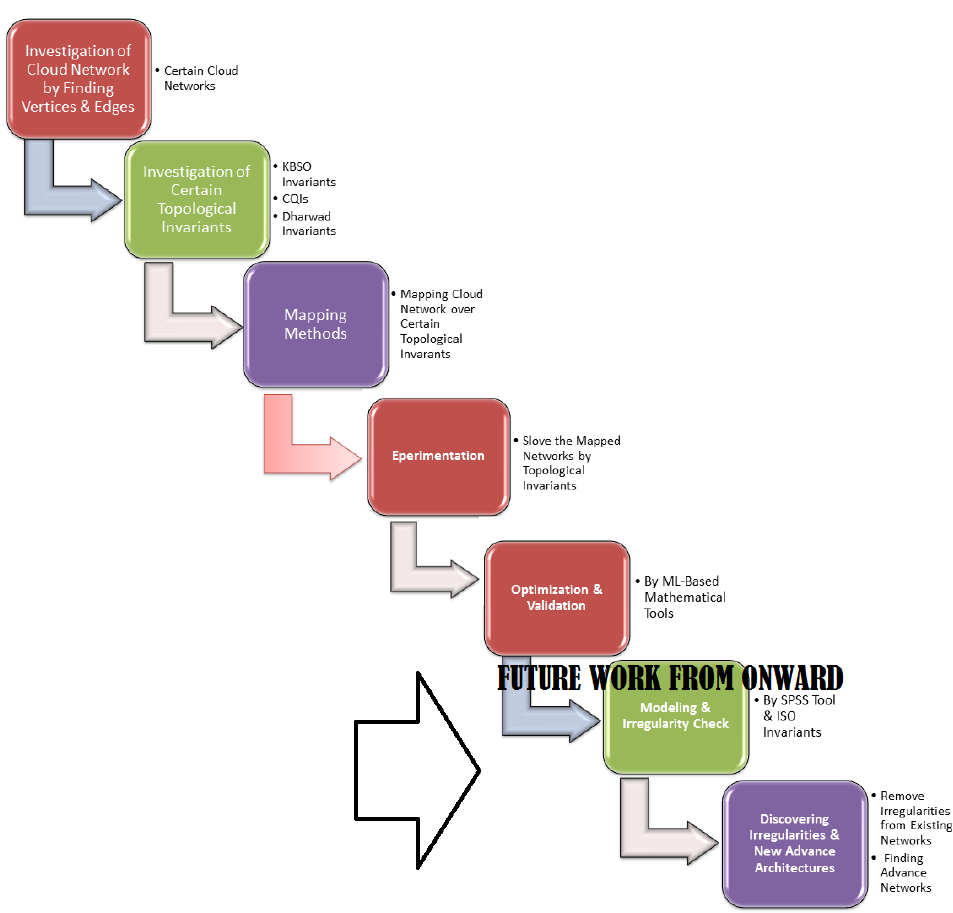
Figure 1. Methodology flow diagram.